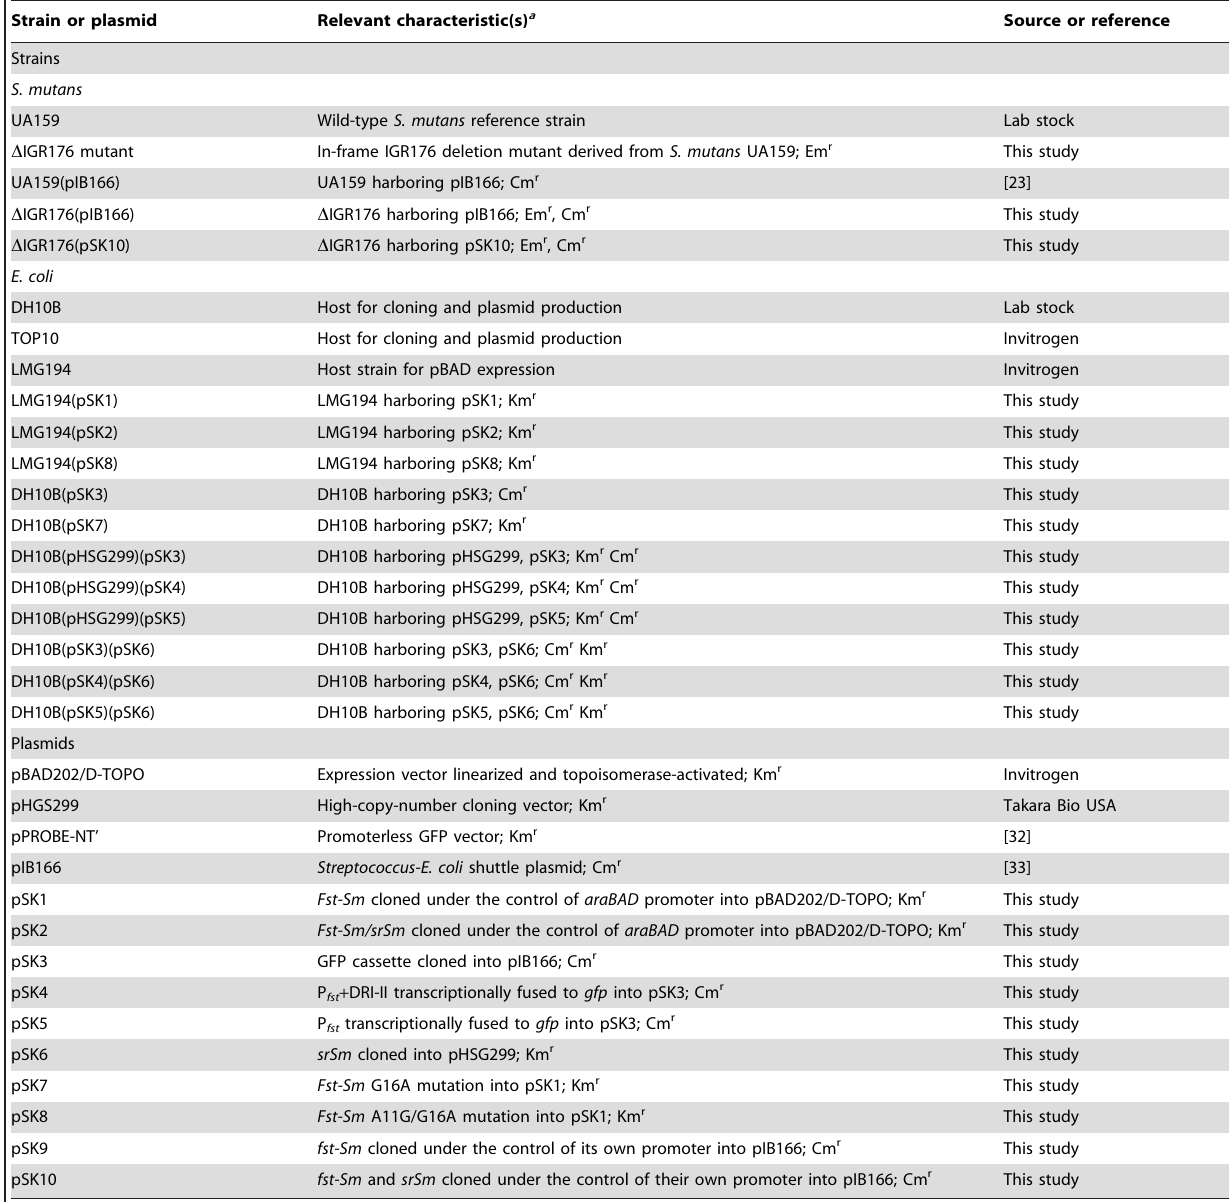
Strain or plasmid Relevant characteristic(s) a Source or